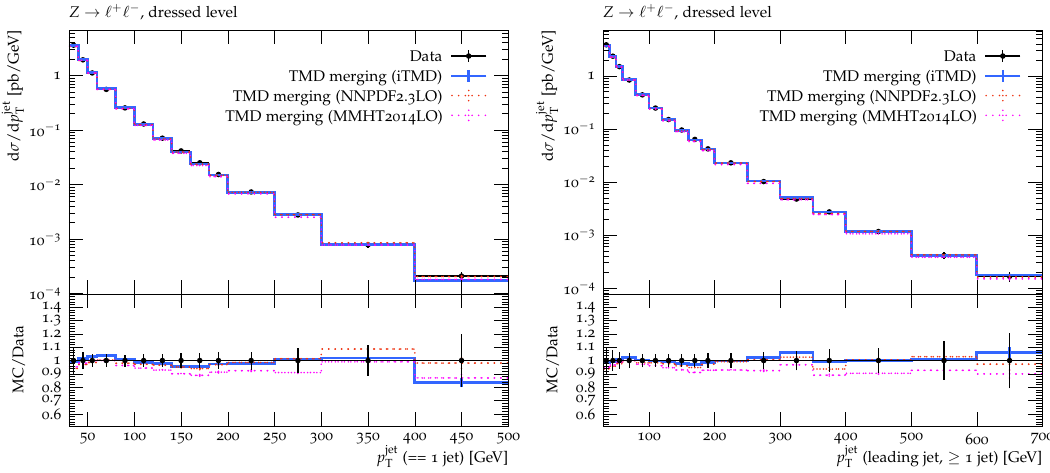
Figure 34 . Exclusive (left) and inclusive (right) leading-jet p T spectra in Z +jet events: PDF